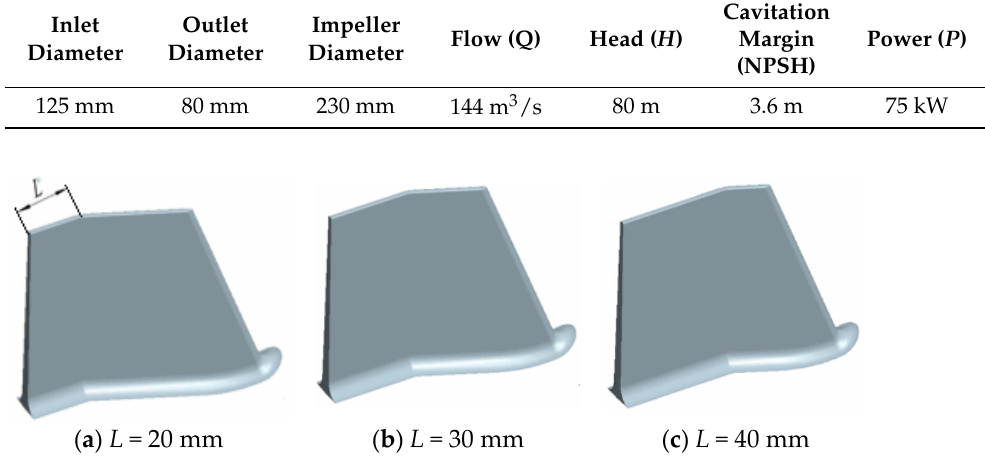
Table 1. The vortex pump parameters.